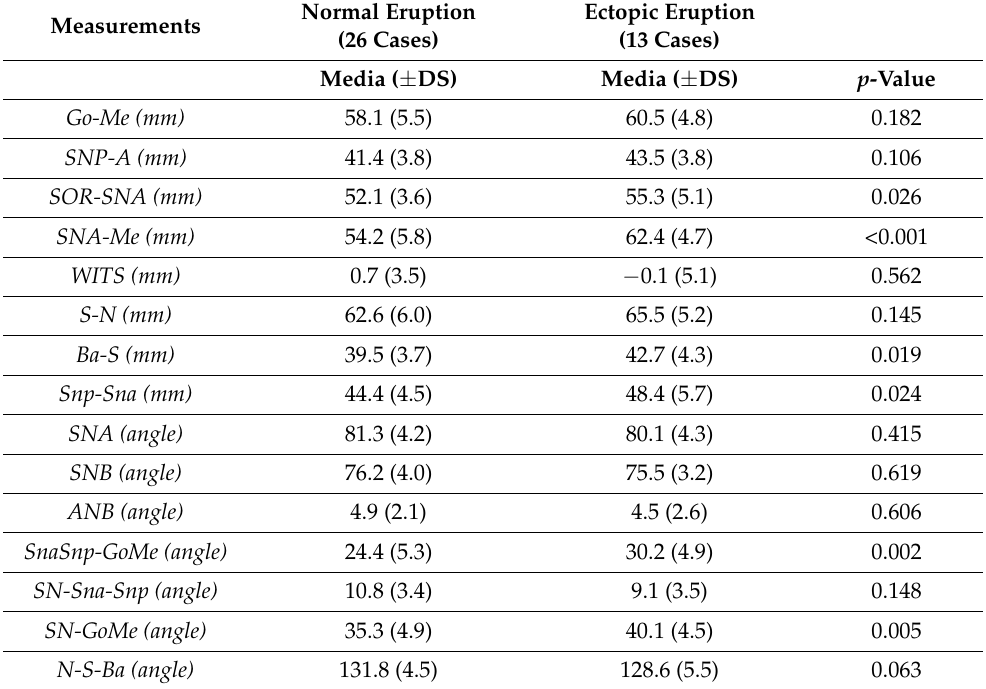
Table 1. Lateral cephalographic analysis of normal and ectopic eruption group (mean and standard